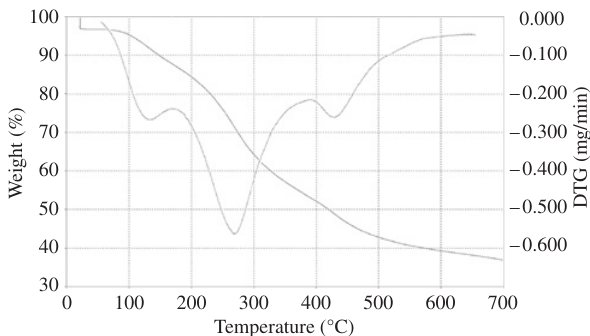
Figure 5: Thermogravimetric analysis (TGA) and derivative thermo- gravimetric (DTG) curves of iron nanoparticles (INPs); the weight loss below 200 ° C was due to water evaporation and decomposition of biologic matrix resulted in 30% weight loss which makes the main peak in the DTG curve.